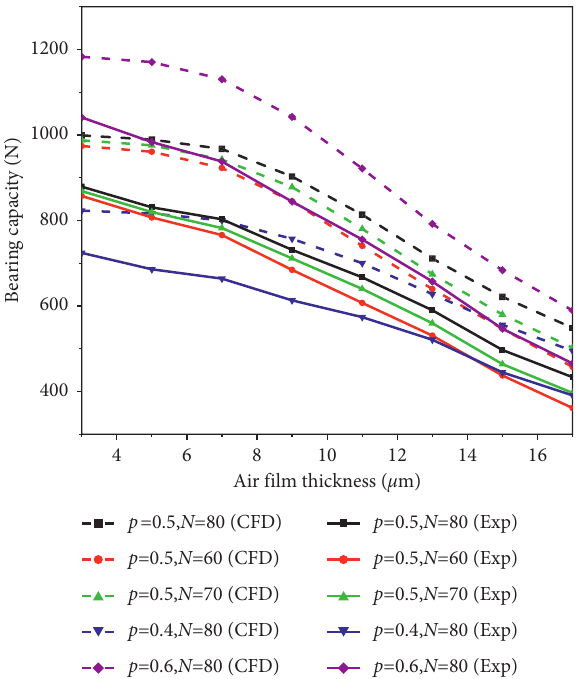
Figure 14: Comparison between simulation calculation value and experimental test